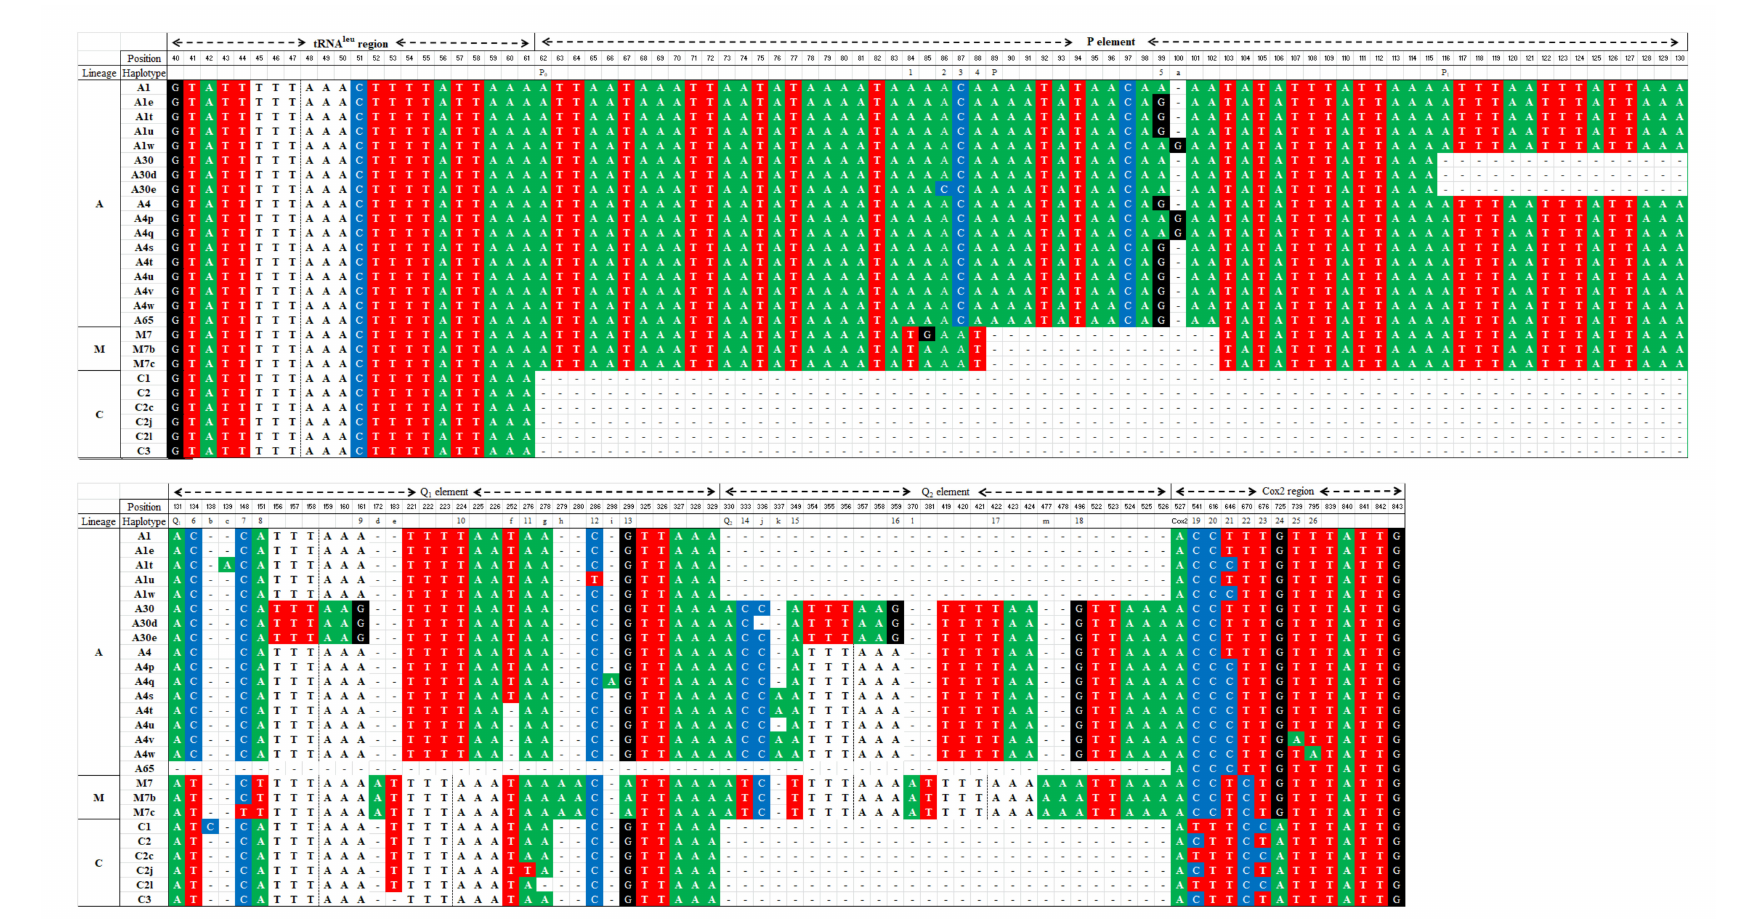
Figure 2. Variable sites of the tRNA leu -cox2 intergenic region showing variation among haplotypes of lineages C, A, and M identified in Peruvian honey bee populations. Substitution sites are numbered from 1 to 26. Indels (indicated with a dash) are denoted by letters from “a” to “m”. The large deletions d and d1 , typical of the P and P 1 forms of the P element, are represented by gray italic letters. Dra I recognition sites (TTTAAA) are indicated by nucleotides in bold with a white background. The absence of the P element characterizes lineage C. Sub-lineage A I carries the P 0 form of the P element, whereas sub-lineage A III is identified by the P 1 form of the P element (indicated by the “ d1 ” deletion). Haplotypes of lineage M are mostly differentiated by the P element (indicated by the “ d ”